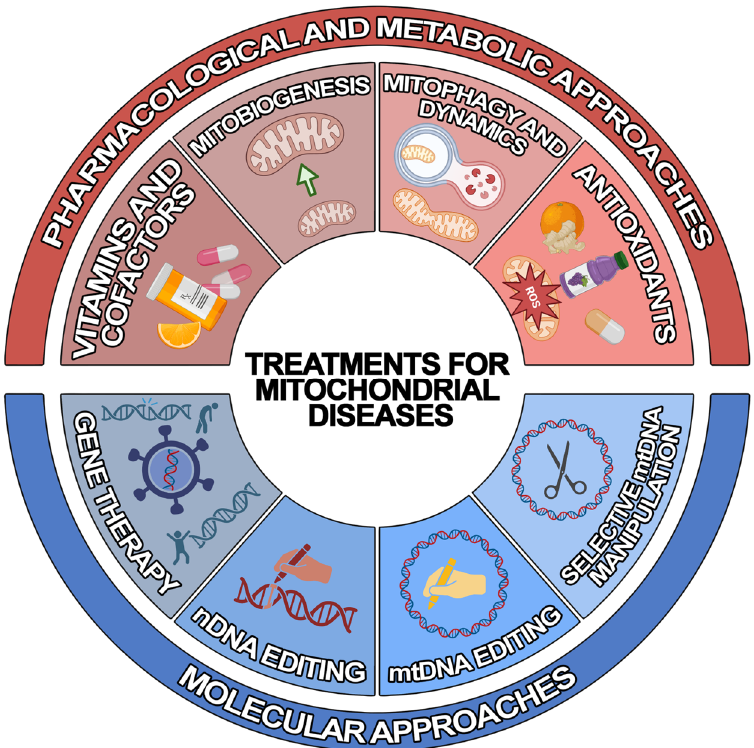
Figure 1. Schematic representation of the treatments for mitochondrial diseases. Illustrated are the current treatment strategies for mitochondrial diseases, which can be classified into pharmacological and metabolic (red) and molecular (blue) approaches.